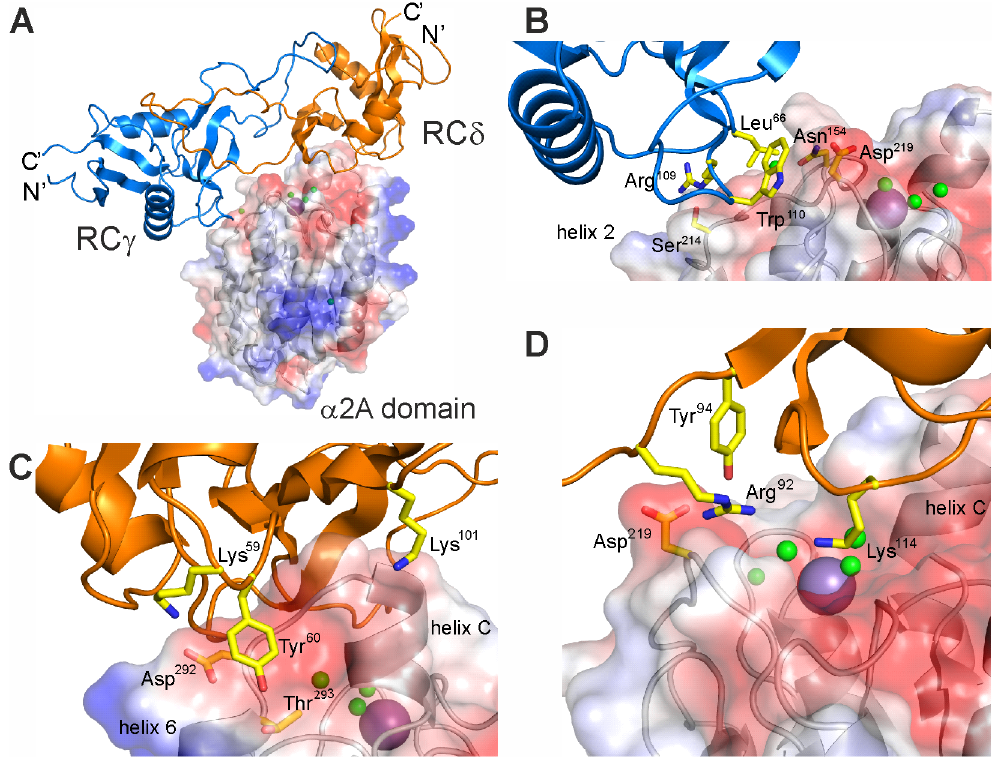
Fig 2. The molecular structure of the RC γδ - α 2Acomplex. ( A ) Molecularstructure of the RC γδ - α 2Acomplex reveals that RC γδ binds on the top and lateral faces of the α 2A domain.The RC γδ subunitcovers the collagen bindingcrevice of the α 2A domain,with its long axis perpendicular to the collagen–ligandinteraction. (B) Detailed view of the interactionsite betweenthe RC γ chain and loop 2 of α 2A. ( C , D ) Two different views of the interaction site betweenthe RC δ subunitand helix C of α 2A. The α 2A domain is shown as a transparentsurface in ( A ) through ( D ), with the key bindingresidues labelled,whilethe water moleculesand magnesiumion are represented as green and purplespheres,